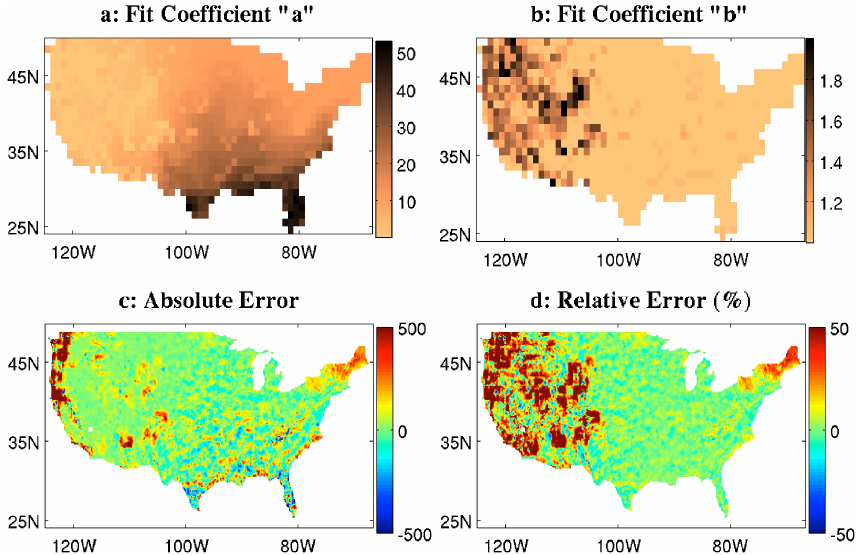
Figure 6. Evaluation of observational estimates of R . Method 3: erosivity calculated from annual modified Fournier index F , using the formula R = a · F b (a) The multiplicative coefficient “ a ” in the above formula, calculated by regression on the grid-points in each 1 ◦ × 1 ◦ box (b) , as in (a) , but for the coefficient “ b ”. (c) Absolute error between the estimate of R in Fig. 3e and the target field in Fig. 3a. (d) Relative error in